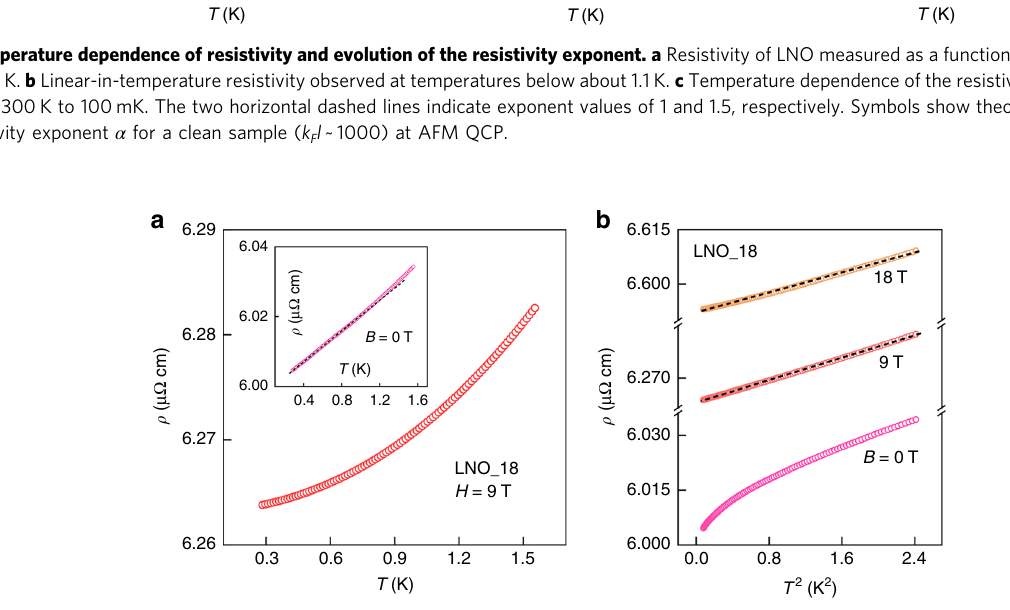
Fig. 2 Temperature dependence of resistivity under a magnetic fi eld. a Resistivity measurement under a magnetic fi eld of 9 tesla for LNO_18. Inset shows the linear-in-temperature behavior under zero fi eld. b Temperature dependence of resistivity plotted versus the square of temperature for different magnetic fi elds. The measurements at B = 9 and 18 tesla show a linear dependence on T 2 . Note the positive magnetoresistance. The standard deviation of the mean at each point is smaller than the symbol size. The black dashed lines in b and the inset of a are straight guidelines.